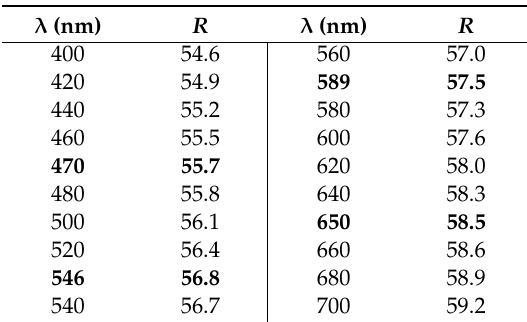
Figure 3. Back-scattered electron images (BSE) ( A , C ) and digital image in reflected plane polarized light ( B , D ) showing tsikourasite from the chromitite of Agios Stefanos. Abbreviations: Tsk = tsikourasite, Epx = epoxy, Chr = chromite, NiP = Ni-allabogdanite or Ni-barringerite, VS = V-sulphide, Aw = awaruite, Npd = nickelphosphide. Scale bar = 10 µ m. Table 2. Reflectance values for